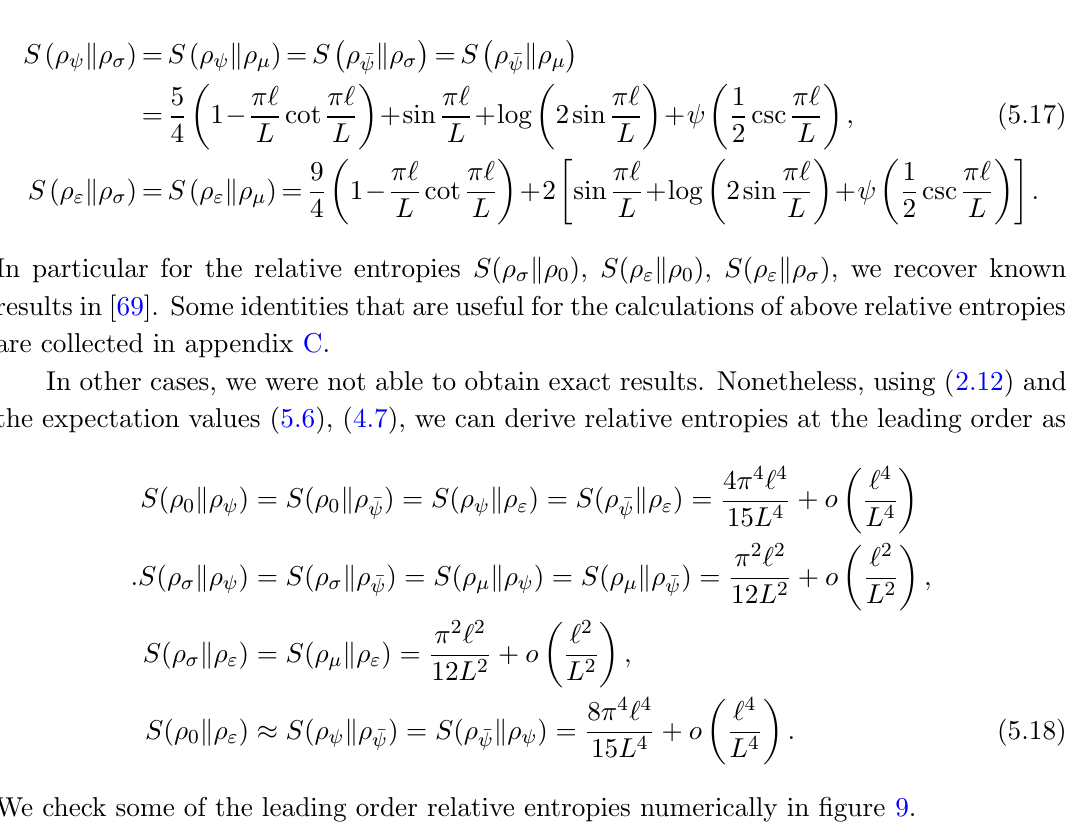
Figure 9 . Relative entropy S ( (cid:26) k (cid:27) ) as a function of the ratio between the subsystem ‘ and the system size L in the free fermion theory. Solid lines are the CFT short distance prediction, eqs. (5.14) to (5.18). The symbols joined by dashed lines represent numerical data, with di(cid:11)erent symbols corresponding to di(cid:11)erent L . Di(cid:11)erent colours correspond to di(cid:11)erent pairs of states (cid:26) and (cid:27)